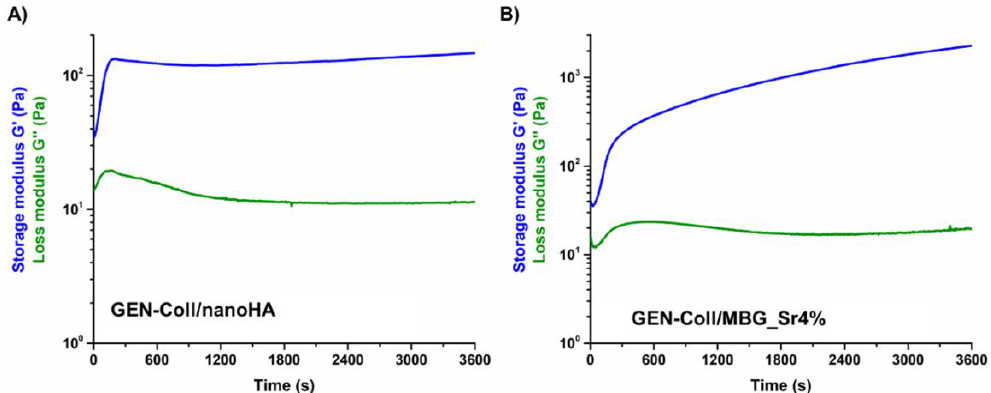
Figure 4. Sol–gel transition of GEN-Coll/nanoHA ( A ) and GEN-Coll/MBG_Sr4% ( B ) at 37 ◦ C. Figure 4. Sol – gel transition of GEN-Coll/nanoHA ( A ) and GEN-Coll/MBG_Sr4% ( B ) at 37 °C.